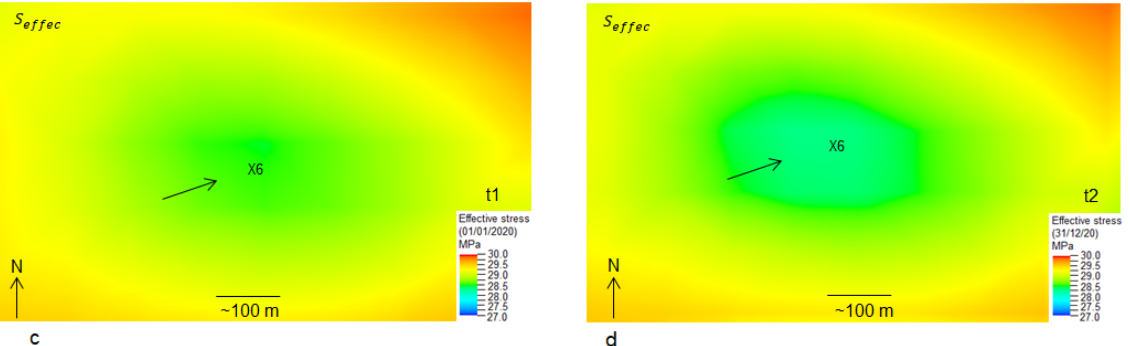
Figure 10. Pore pressure ( P p ) and effective stress ( S ef fec ) changes from t1 (1 January 2020) to t2 (31 December 2020) in the short-term case with one well (X6) with a water cut-off rate of 5 m 3 /day and a random schedule. The arrows show the location of the maximum observed fluctuation in P p and S ef fec from t1 to t2. The color scale is in MPa. ( a ) is pore pressure at time t1; ( b ) is pore pressure at time t2; ( c ) is effective stress at time t1; ( d ) is effective stress at time